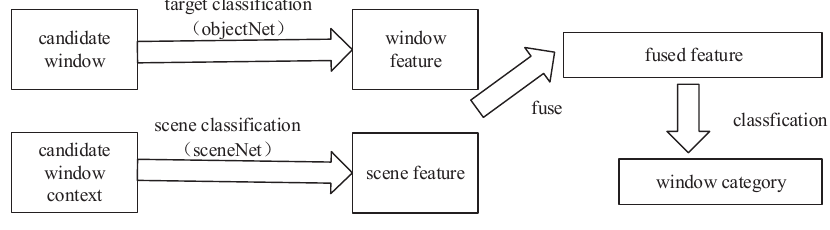
Figure 11. Window feature and context scene feature fusion.